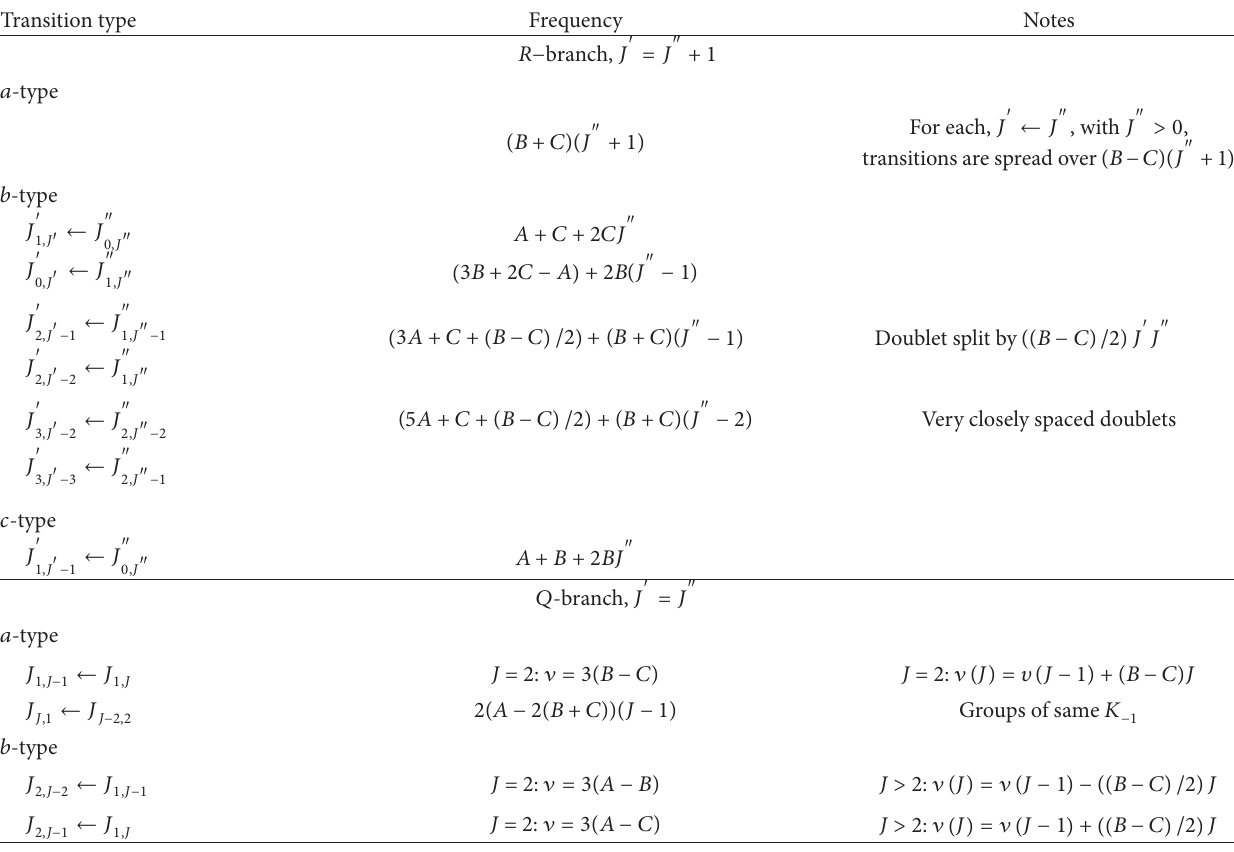
T 1: Summary of transition patterns and